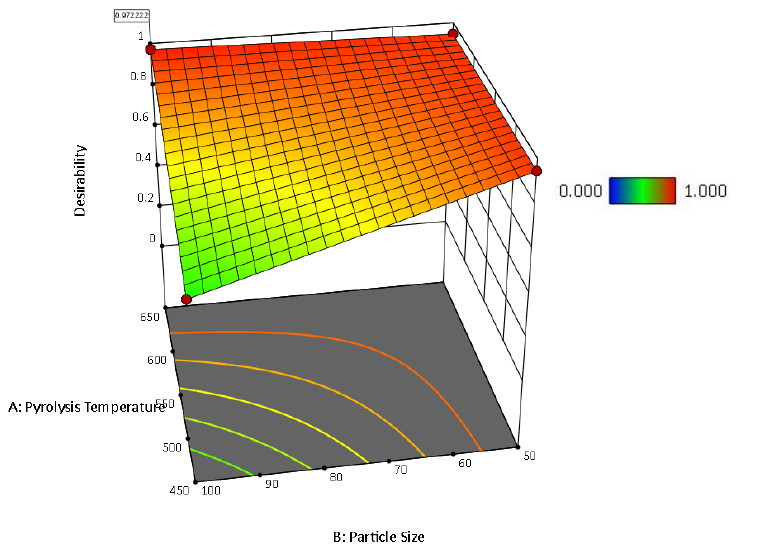
Figure 18. Surface response of the desirability of the water absorptivity of switchgrass biocarbon- filled composites as a function of pyrolysis temperature and particle size when the particle loading is 20%.